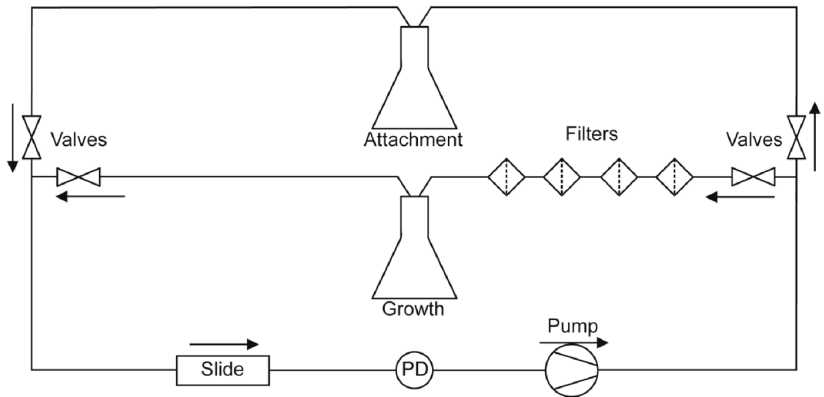
Figure 1. Schematic of Flow System. Cell-seeded media circulates from the attachment flask for the first 2 h, during which time both valves to and from the growth flask are closed. After 2 h, the valves to and from the attachment flask are closed and those of the growth flask are opened, allowing circulation of cell-free media for the remainder of the experiment (additional 16 h). Media is maintained as cell-free using four sequential filters. Arrows indicate direction of flow. PD: Pulsation Damper, used to reduce pulsation of slide surface caused by pump.